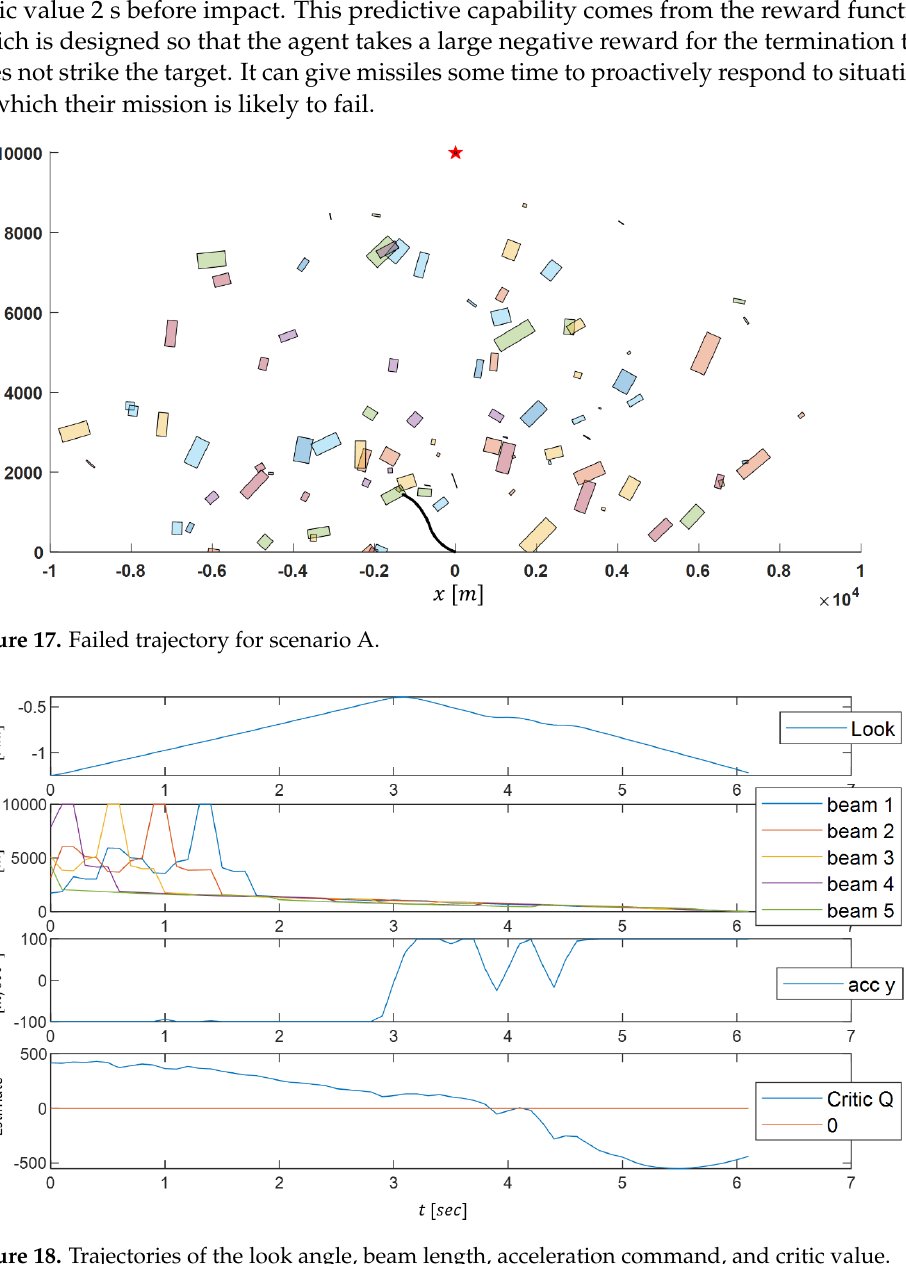
Figure 18. Trajectories of the look angle, beam length, acceleration command, and critic